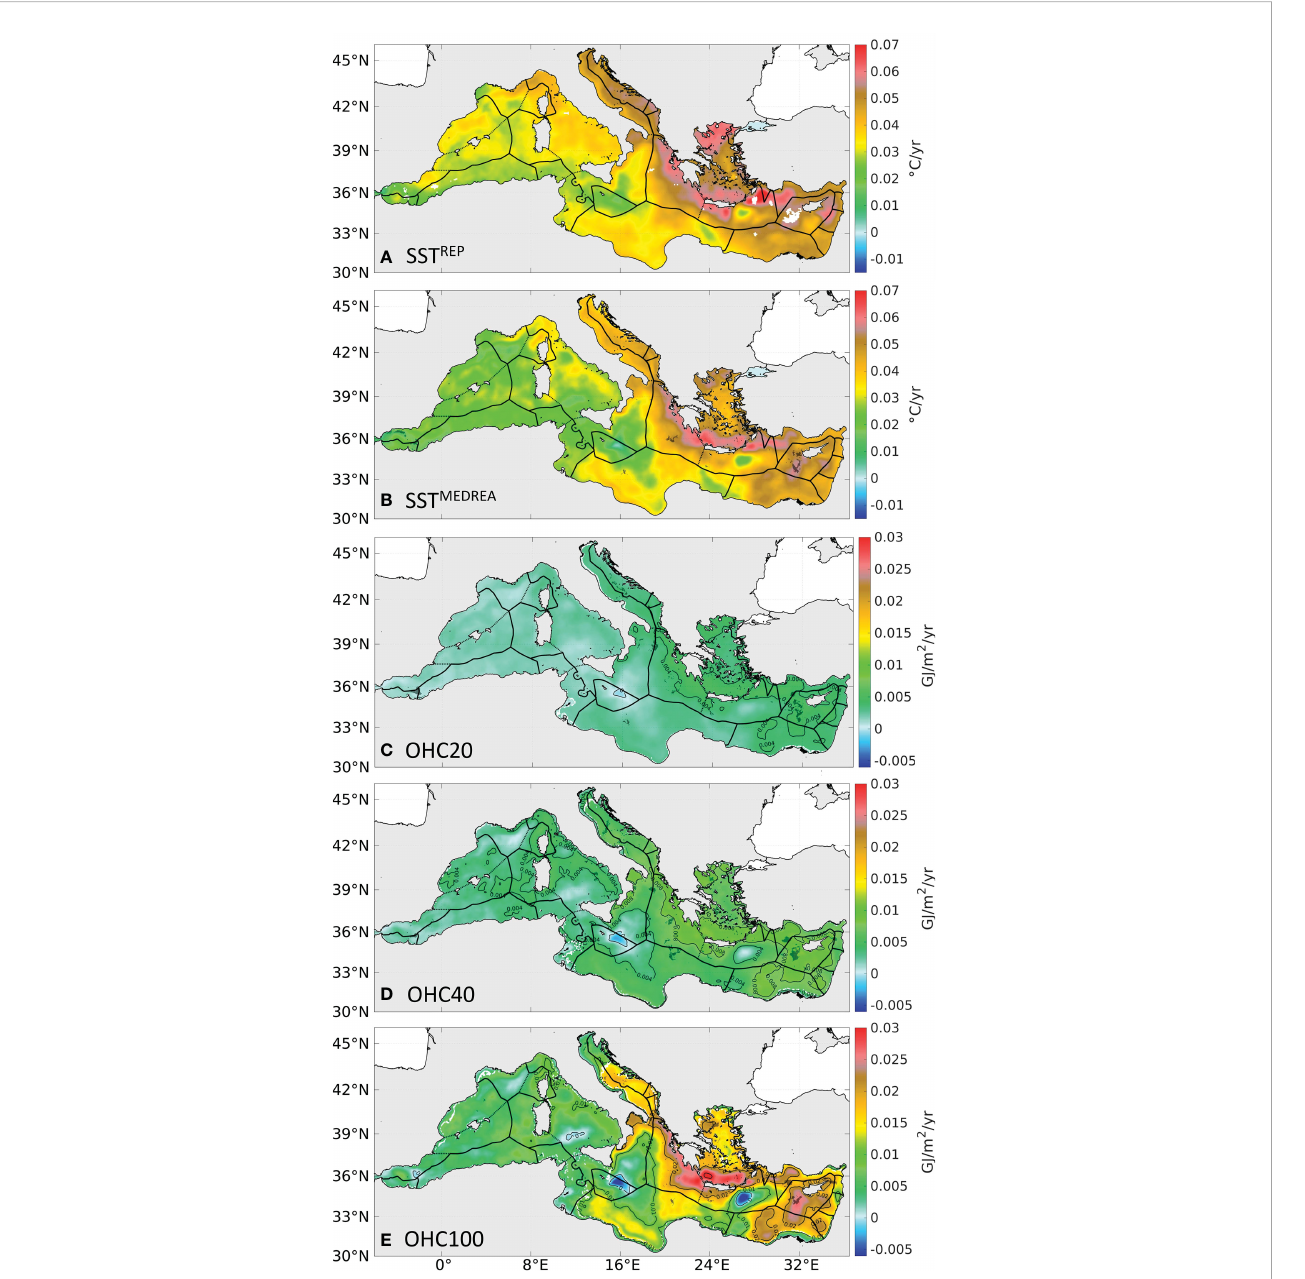
FIGURE 2 Linear trends over the period 1987-2019 of SST (in °C/year) from REP (A) and MEDREA (B) , and of OHC within the layers [0-20 m] (C) , [0-40 m] (D) and [0-100 m] (E) from MEDREA (in GJ/m 2 /year). Not signi fi cant values at the 95% con fi dence level based on a Mann-Kendall trend test are